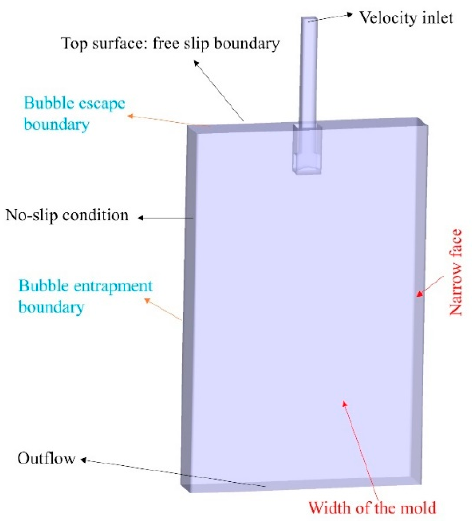
Figure 2. Schematic diagram of the mold with boundary conditions. Table 2. Geometry parameters and operation conditions.